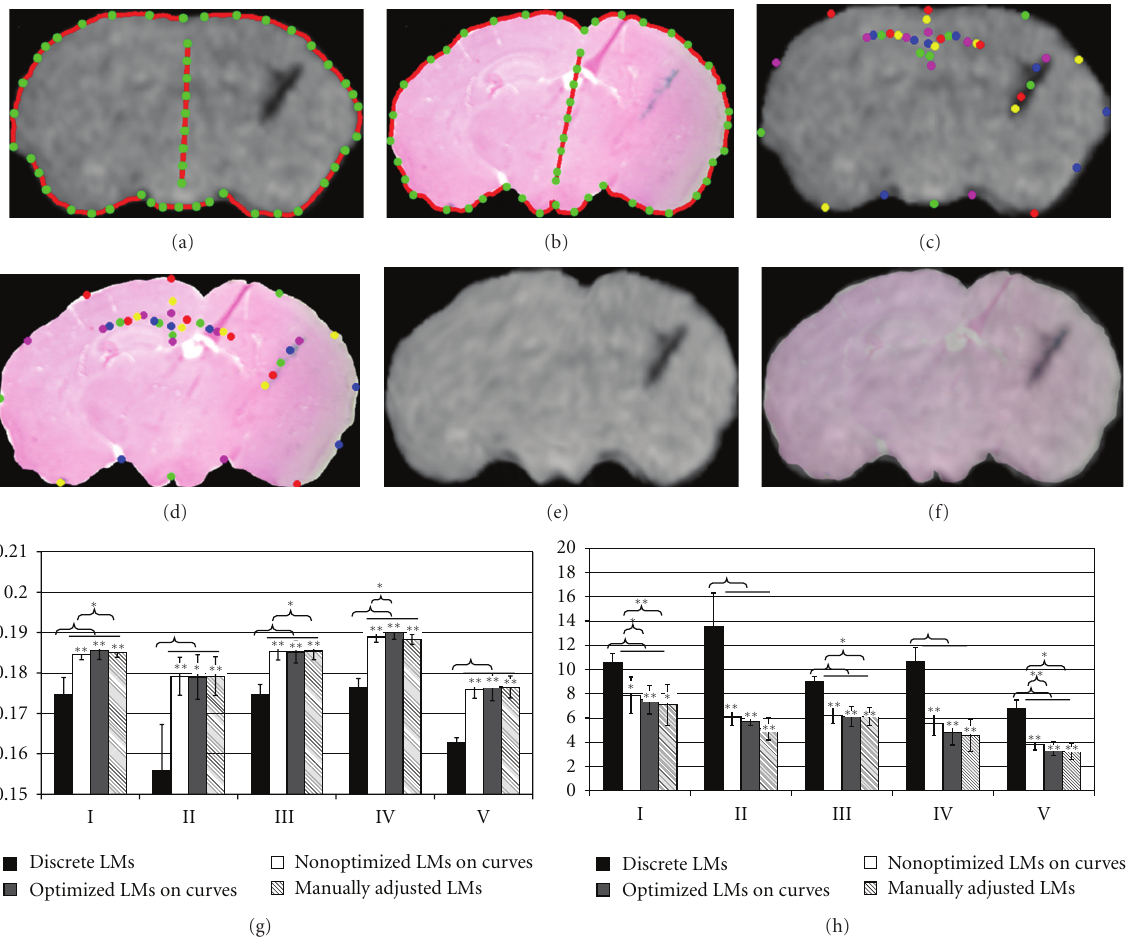
Figure 2: The registration of MRI and histological slices using optimized landmarks on curves (a) and (b), manually selected discrete landmarks (c) and (d). The colors of homologous landmarks are matched in (c) and (d). The MRI slice transformed using the thin-plate splines with optimized landmarks in (a) and (b) is shown in (e), and overlaid on the histological section (f). The average NMI and TRE of transformed MRI and histological slices in five image pairs (I–V) were shown in (g) and (h), respectively. The NMI and TRE were calculated on the MRI slices transformed using manually selected “discrete landmarks (LMs)” (black columns), landmarks generated on curves but not optimized (“Nonoptimized LMs on curves”) (white columns), curve landmarks optimized using (1) (“Optimized LMs on curves”) (gray columns), and curve landmarks manually refined (“Manually adjusted LMs”) (stripped columns) ∗ : P < 0.1; ∗∗ : P <